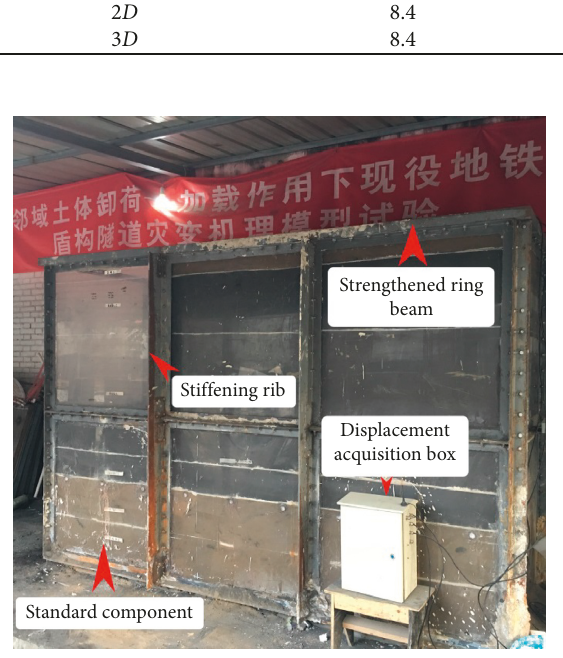
Figure 1: Model test